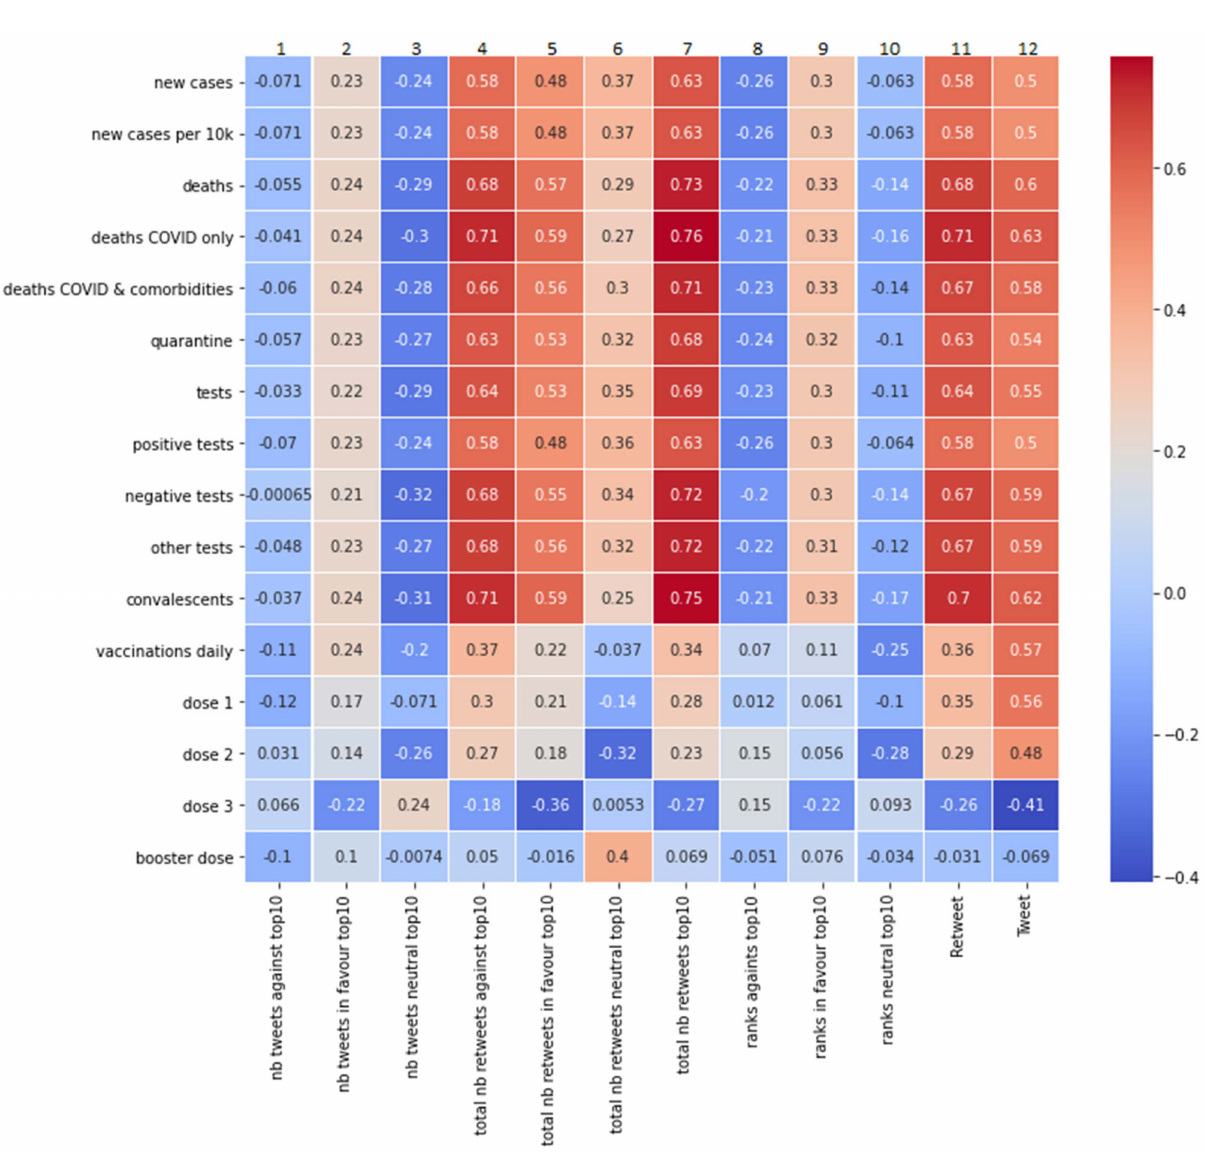
Figure 8. The measures of Pearson’s linear correlation between the COVID-19 epidemiological data and the sentiments expressed in the top-10 tweets. The total number of retweets for the top-10 tweets of all sentiment categories (column 7) correlates strongly with most medical